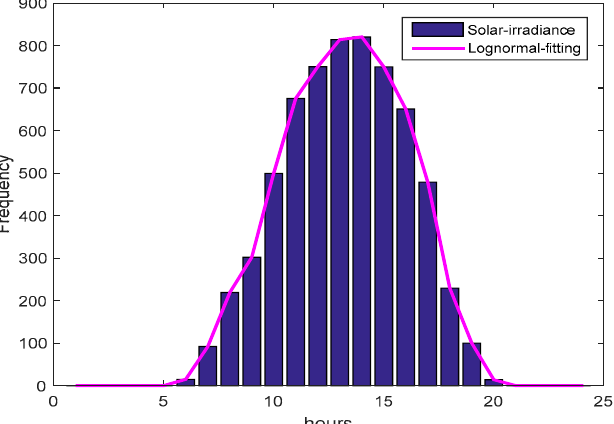
Figure 3. Illustrations of frequency for solar (mean=2,SD=3)variation.